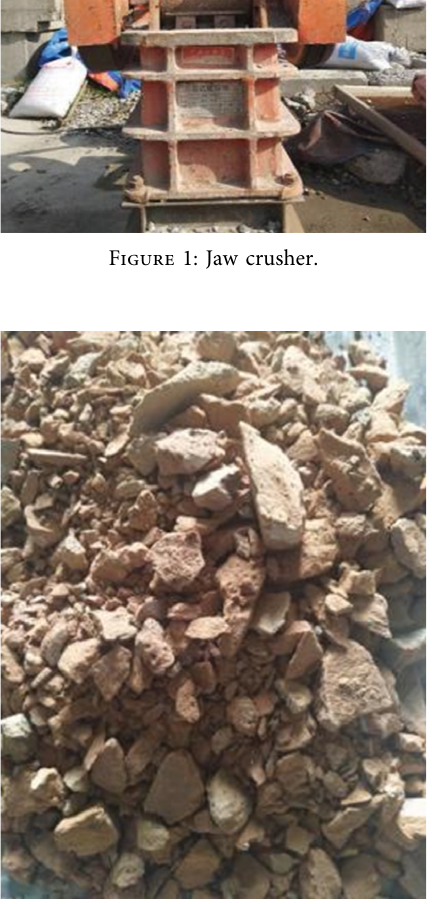
Figure 2: Recycled waste brick aggregate.